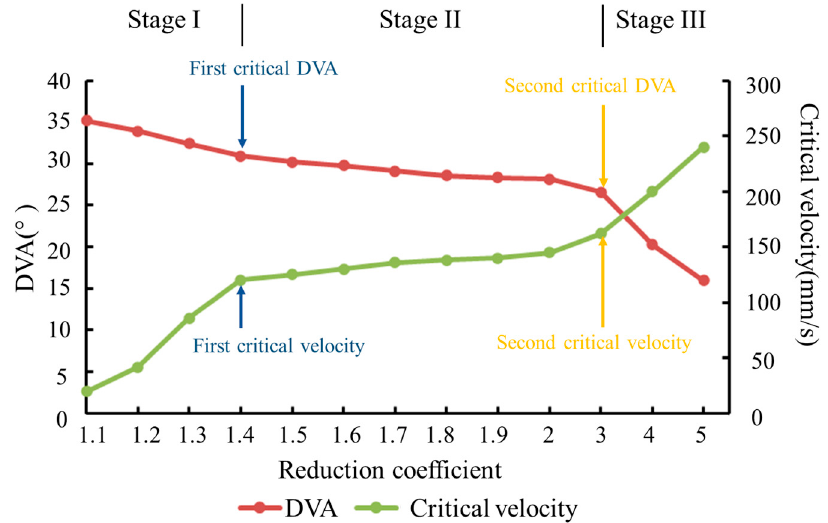
Figure 12. Comparison of DVA, critical velocity, and reduction coefficient of the